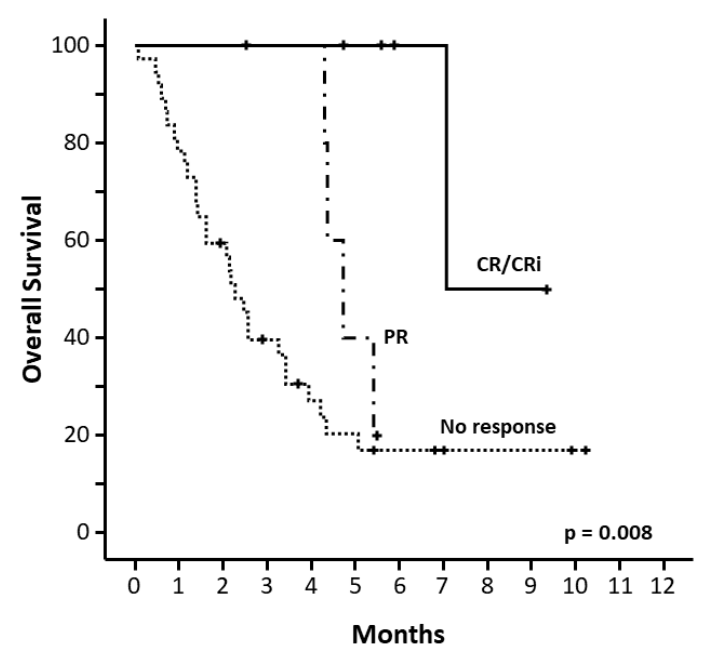
Figure 2. Overall survival from the start of venetoclax according to response. Table 2. Multivariate analysis of factors influencing survival in R/R-AML patients treated with ve- netoclax.